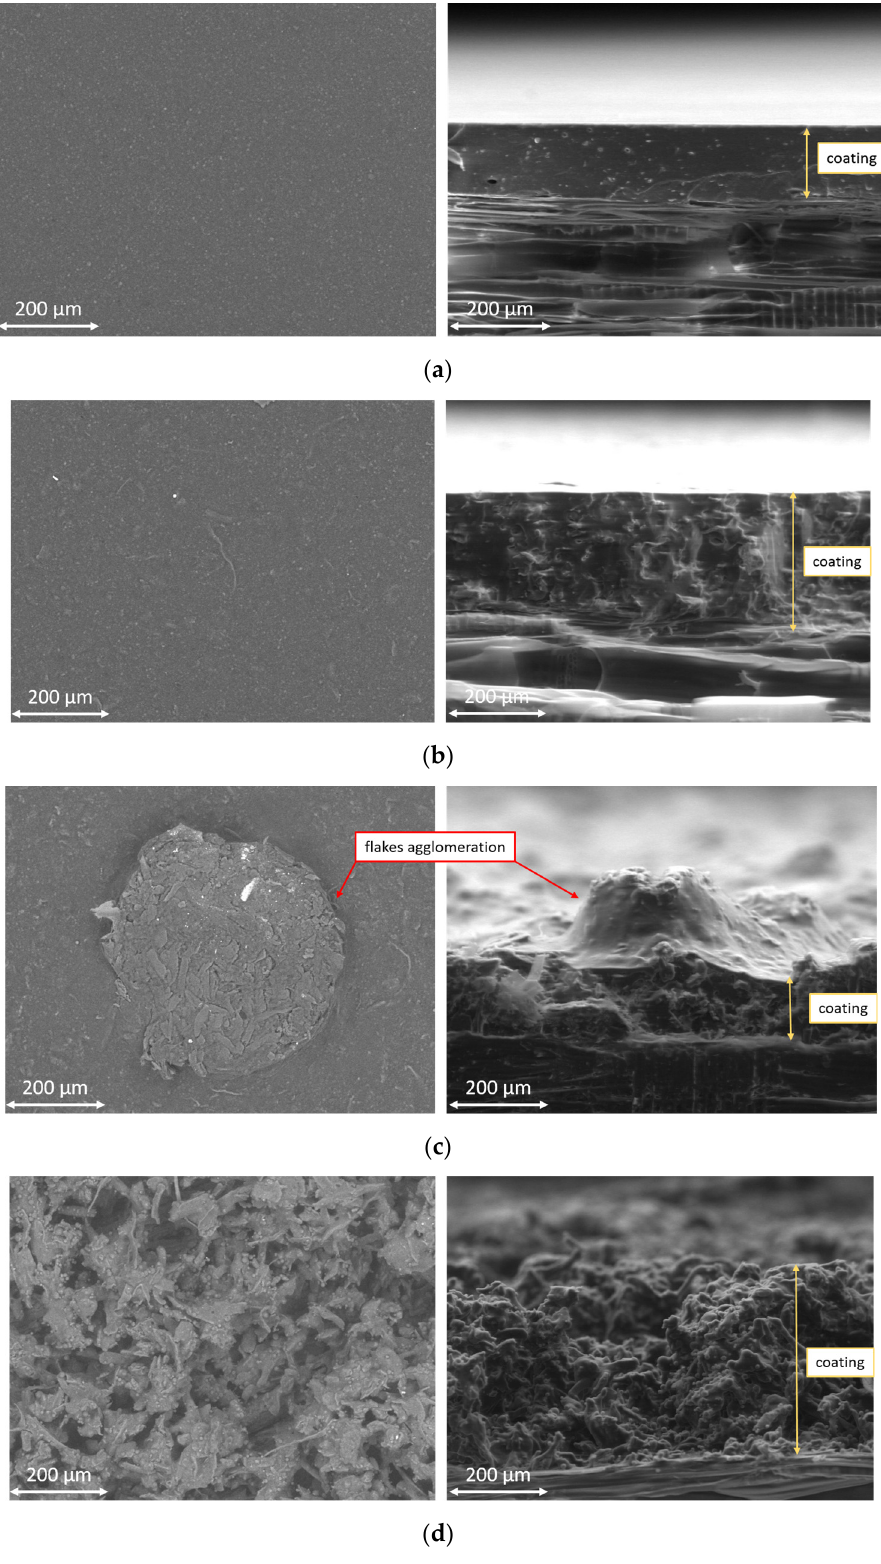
Figure 2. SEM micrograph of ( a ) sample F0, ( b ) sample F5, ( c ) sample F10 and ( d ) sample F20. Top view on the left and cross section on the